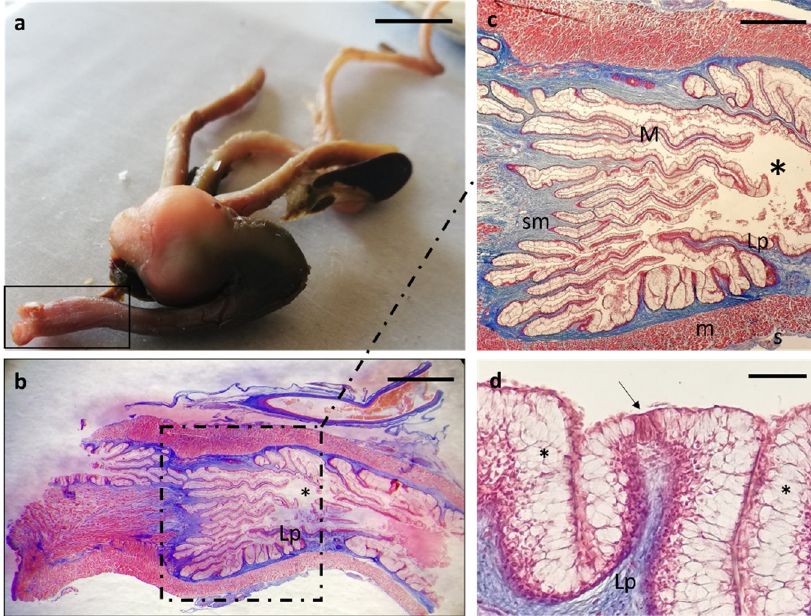
Figure 8. ( a ) Gross anatomy of the gastrointestinal tract: esophagus (rectangle). ( b – d ) Masson Trichrome with Aniline Blue staining. ( b ) Stereomicrographs of the esophagus sagittal section: goblet cells (asterisk), lamina propria (Lp). ( c ) Histological organization of the esophagus of H. niloticus : sagittal section showing mucosa (M), lamina propria (Lp), submucosa (sm), internal muscular layer (m), serosa (S). ( d ) Micrograph of a mucosa detail: taste bud (arrow); goblet cells (asterisks) lamina propria (Lp). Scale bar: 1 cm ( a ), 500 μ m ( b ), 100 μ m ( c , d ).